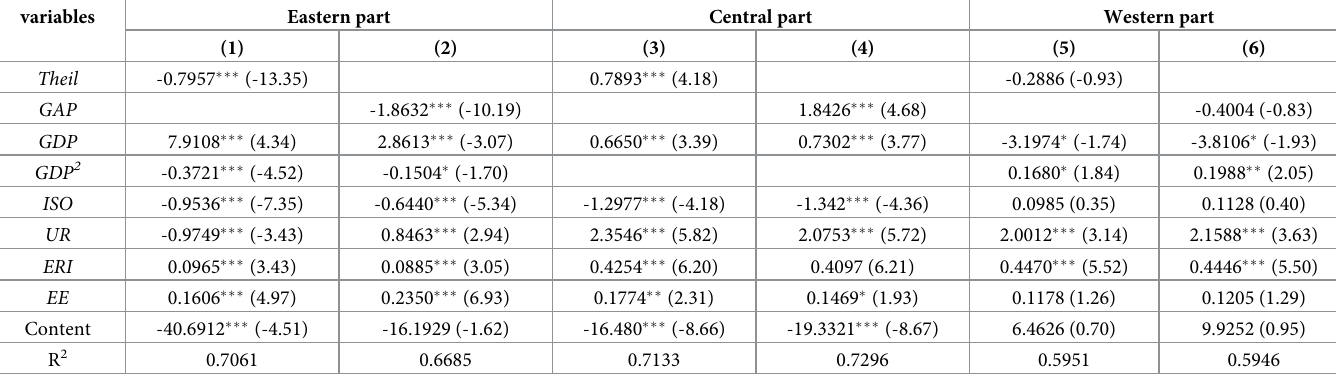
Table 6. Results of the urban-rural income gap on carbon emission reductions by region.